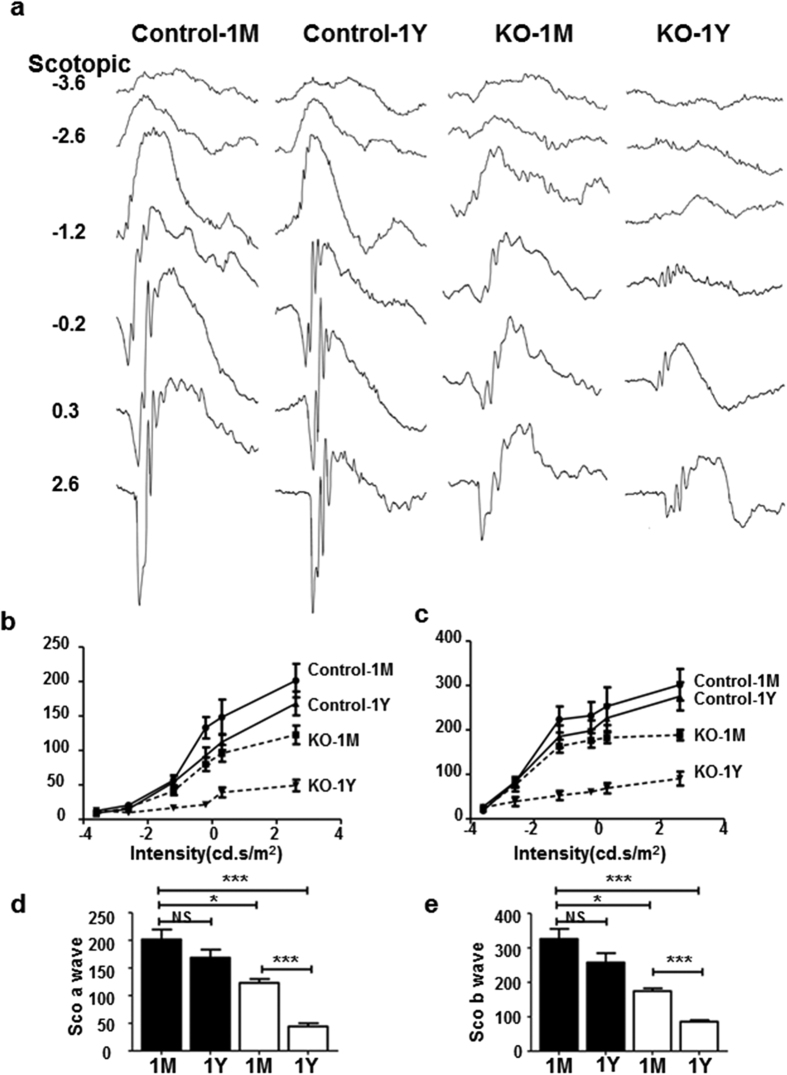
Ezh2 deletion impairs postnatal photoreceptor cell function.(a) Representative ERG waveforms of control and KO mice that were subjected to flashes of increasing intensities under scotopic conditions, which isolate rod photoreceptor-mediated responses. (b–e) The amplitudes of scotopic ERG a- and b-waves, which measures cone responses: Black bar, WT controls; white bar, KO. Note the abnormal and progressive reduction of ERG a- and b-wave amplitudes in KO mice from 1 M to 1 Y. Data represent the mean ± S.D. of at least six biological replicates. NS indicates no significant difference; *indicates P < 0.05; **indicates P < 0.01; ***indicates P < 0.001.